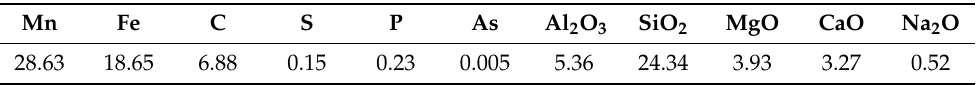
Table 1. Main chemical composition analysis of the coarse manganese concentrate